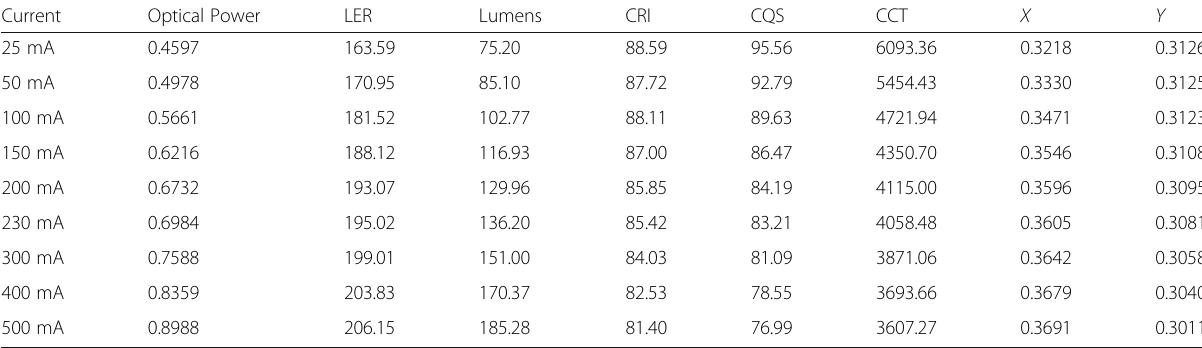
Table 1 CRI, luminous efficacy of optical radiation (LER), CCT, and CIE color coordinates of the white-light emission based on G-, Y-, and O-emitting Cu:ZnInS/ZnS CNCs blends with different weight ratios operated at different current levels Current